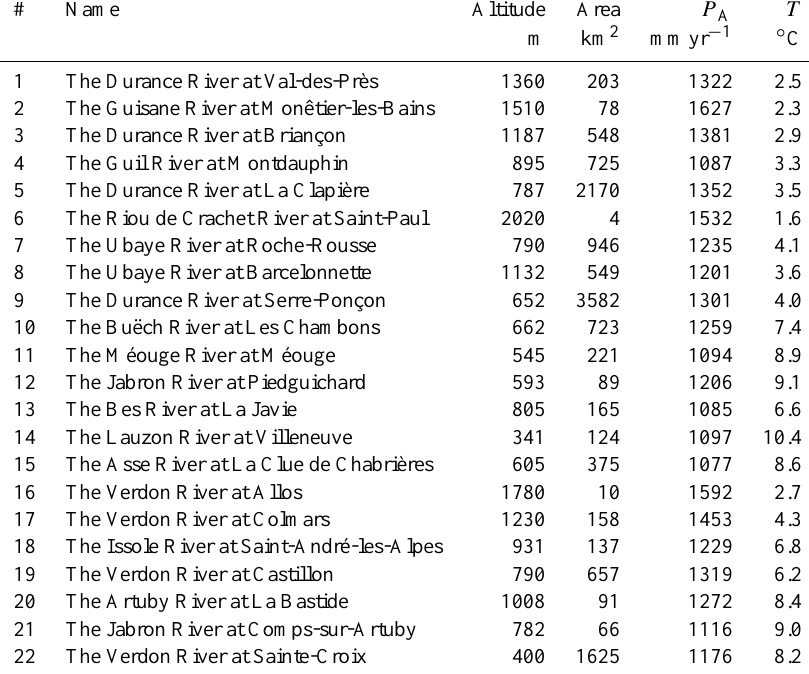
Table 1. Main characteristics of the 22 selected watersheds. The numbers in the first column correspond to those indicated in Fig. 2, P A is the annual mean precipitation (over the period 1948–2010) and T the mean air temperature (over the period 1948–2010).